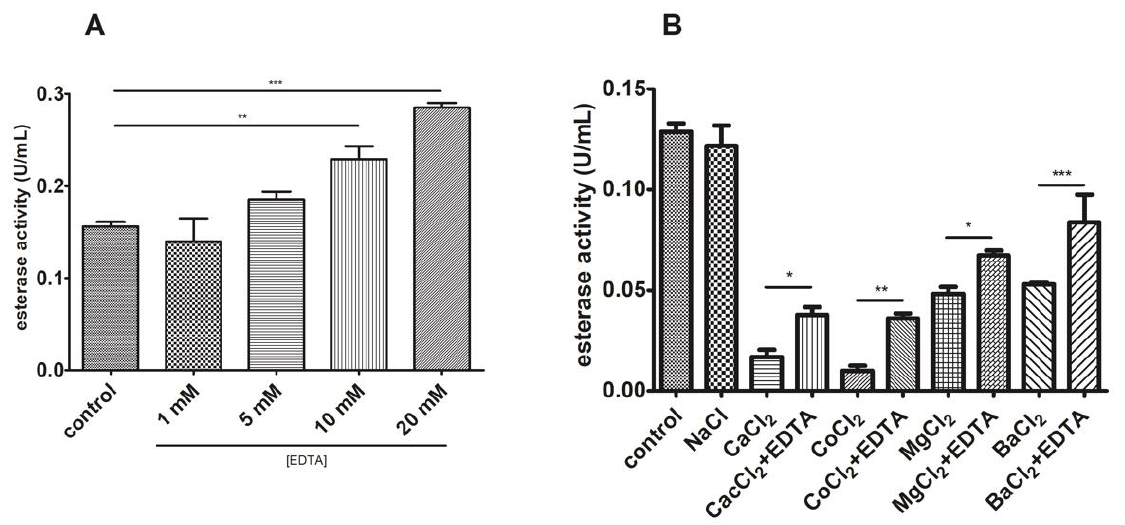
Figure 11. Divalent cations inhibit esterase activity. ( A ) A dose-response relationship was observed between esterase activity and EDTA. ( B ) Assaying with different divalent cations corroborated this and the EDTA addition slightly reduced this impact. * p < 0.05, ** p < 0.01, and *** p < 0.001.